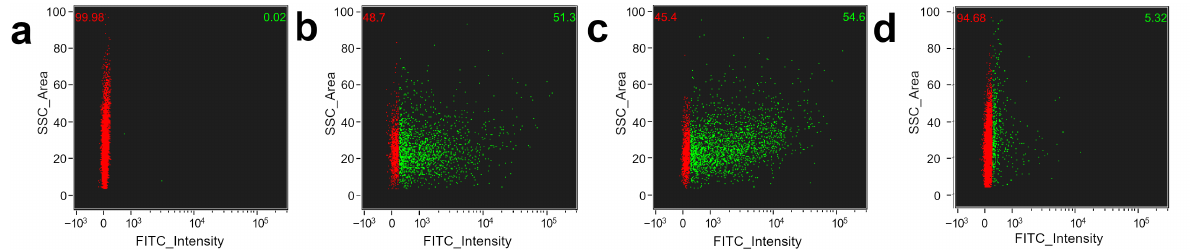
Figure 3. Changes in the platelet population after incubation with BSA-FITC conjugated FeNP observed using a flow cytometer. ( a ) A population of unstained platelets, showing the absence of autofluorescence in the area characteristic to the FITC dye. ( b ) Platelets after 30 min of incubation with magnetite nanoparticles. ( c ) Cells that have undergone a magnetic separation procedure. ( d ) The cell population remaining in the washing effluent. Red and green numbers show the percentage of platelets without and with FeNP, respectively.